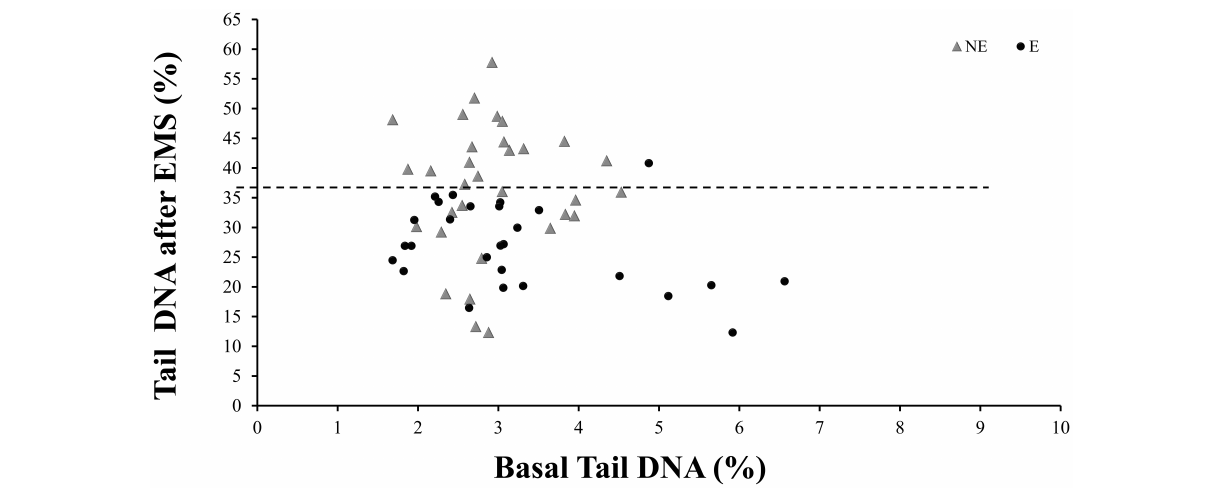
individuals or after their stratification according to exposure,